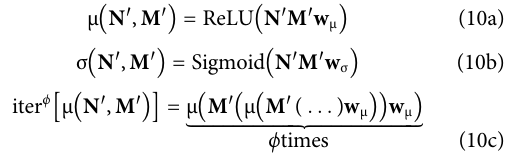
Table 1 summarizes the computation processes of the policy and value functions of the GCN-DDPG agent for bracing direction optimization. In each column, the 1st row indicates if the computation belongs to the policy or the value function. The 2nd row denotes input data used for the computation. The 3rd row indicates the computation process using GCN layers,